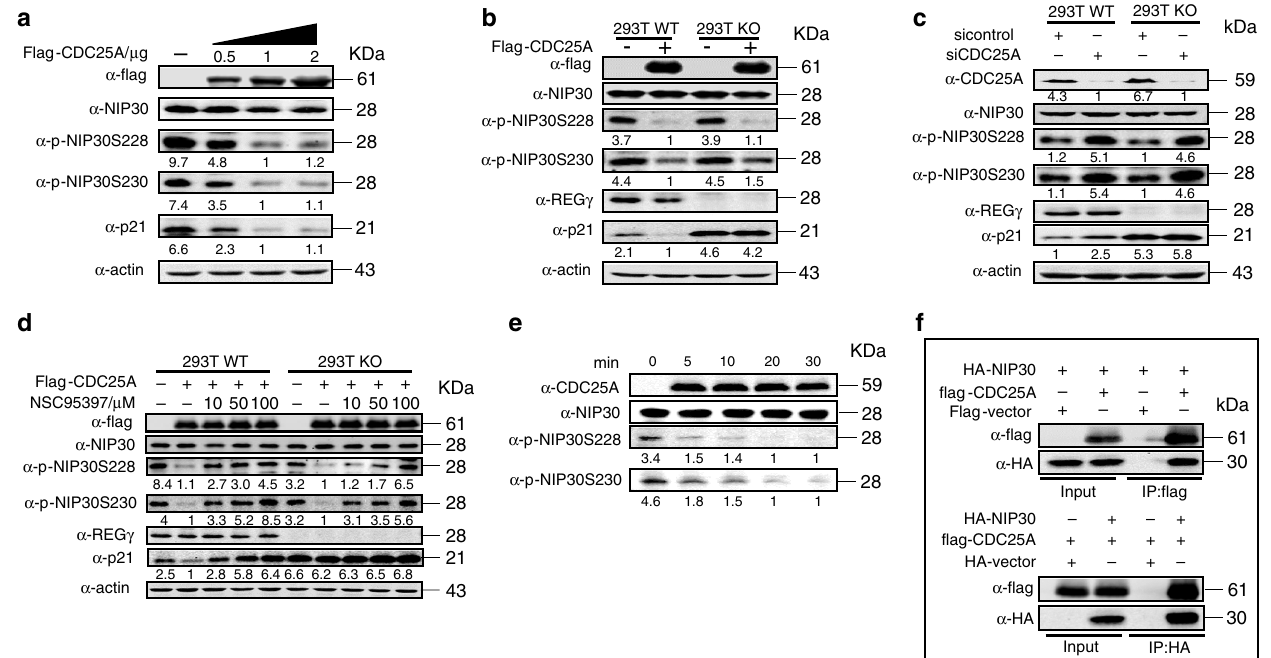
Fig. 3 NIP30 pS228/pS230 is dephosphorylated by CDC25A. a 293T cells were transiently transfected with 0.5 μ g, 1 μ g, or 2 μ g of fl ag-CDC25A plasmid for 48h, and the total cell lysates were analyzed by immunoblotting with antibodies against fl ag, total NIP30, pNIP30Ser228, pNIP30Ser230, p21, and actin. Data are representative of three independent experiments. b REG γ WT and knockout 293T cells were transiently transfected with 2 μ g fl ag-CDC25A